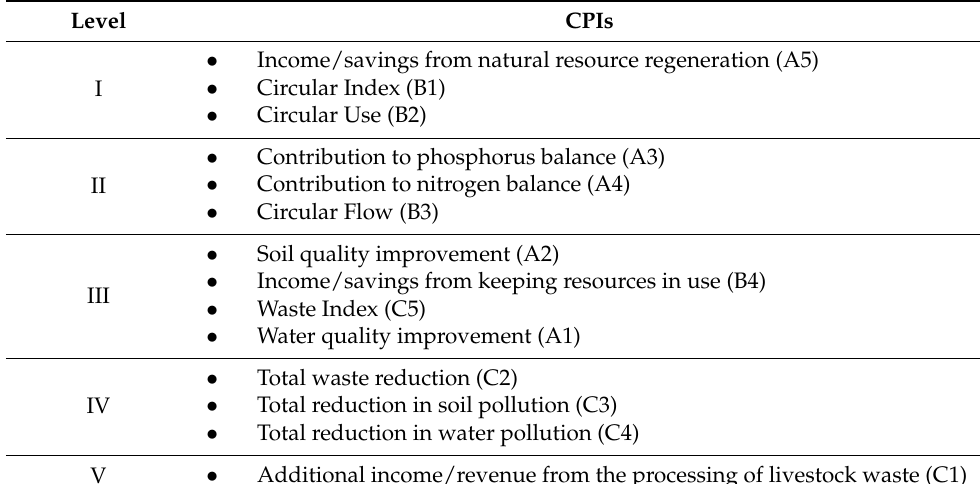
Table 5. The results of the distribution of indicator levels of